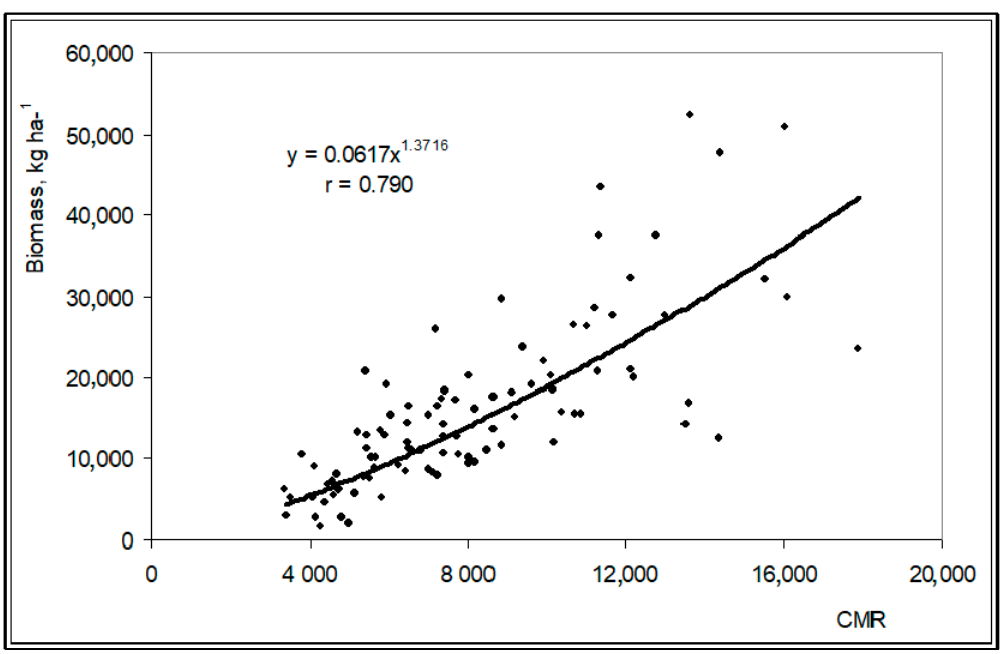
Figure 19. Relationship between capacitance (CMR) measured by the Grassmaster II probe and pasture biomass productivity between March and June2016, in all the twenty four sampling points.